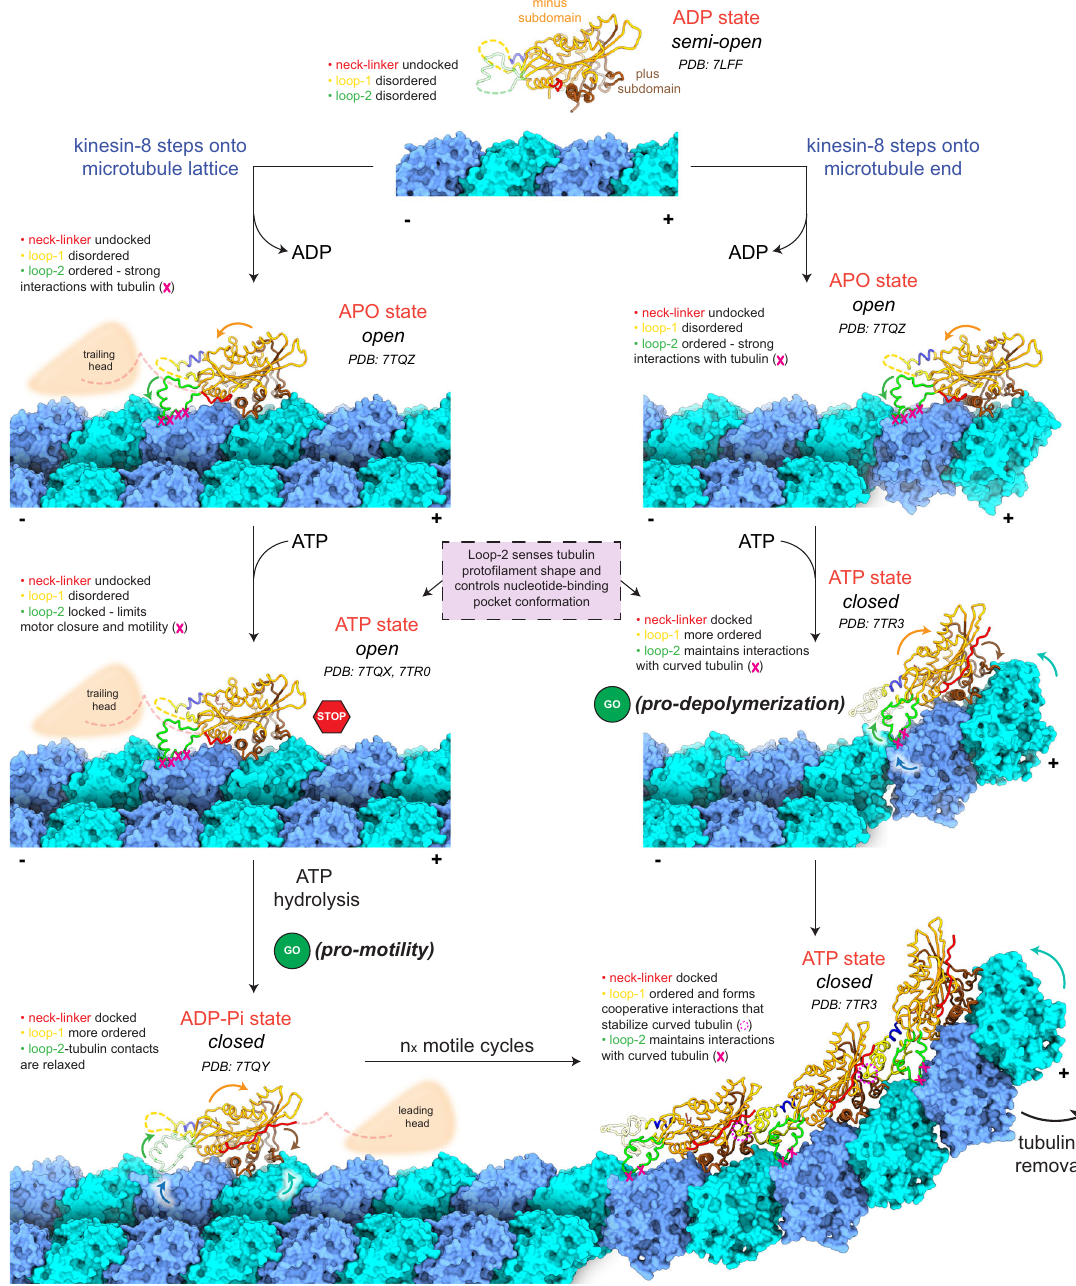
Fig. 7 Model for tubulin shape-induced alternations between pro-motility and pro-depolymerization states of kinesin-8. When kinesin-8 binds tubulin proto fi laments that are constrained to a straight conformation by the lateral proto fi lament interactions of the microtubule lattice (left), the interactions between loop-2 and α -tubulin restrict the motor domain from transitioning to the closed conformation with a docked neck-linker. Unable to stably interact with the preceding motor via loop-1, or to curve tubulin enough to disrupt proto fi lament contacts, some of the loop-2-tubulin bonds eventually break, allowing the motor domain to form the pro-motility state, in which the neck-linker docks and the tethered head is moved to the next αβ -tubulin subunit. Alternatively, when kinesin-8 encounters curved tubulin proto fi laments, or proto fi laments that can become curved, which are found at the microtubule plus-end (right), its motor domain readily forms a pro-depolymerization state. In this state, the elongated loop-2 region moves toward the motor core to accommodate the position of α -tubulin in curved αβ -tubulin subunits. This displacement of loop-2 is accompanied by closing of the ATP pocket to form a nucleotide-hydrolysis-competent active site and a docked neck-linker. In addition, loop-1 becomes more structurally ordered and inserts into the deep groove between loop-8 and the core β -sheet of the preceding motor domain. By maintaining loop-2 contacts with tubulin, and the loop-1 linkage between motors, the conformational transition of multiple motor domains to a closed conformation could increase tubulin proto fi lament curvature enough to trigger microtubule